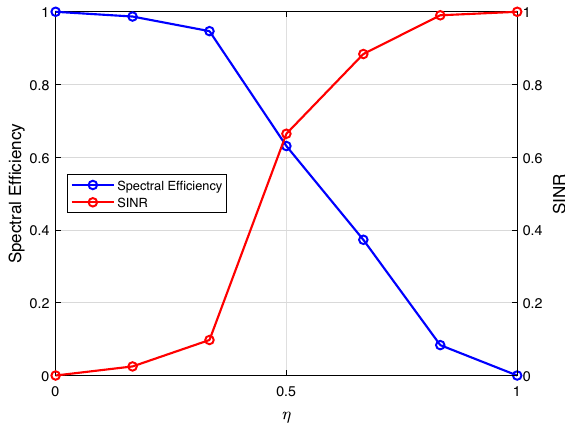
Fig. 3 The normalized spectral efficiency and radar SINR versus tradeoff parameter η with the communication SNR = 0